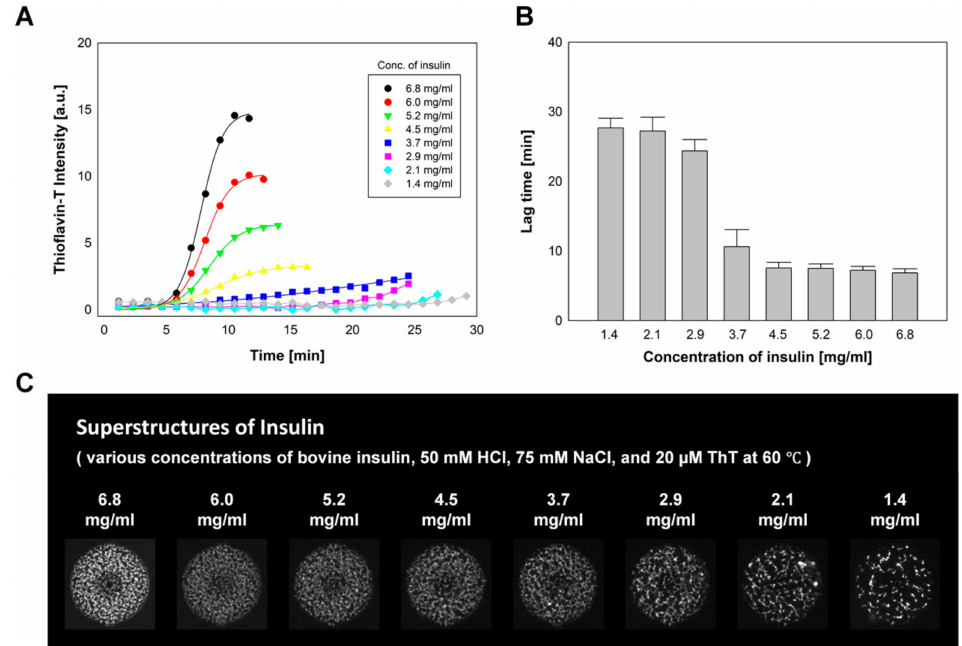
Figure 3. The e ff ect of insulin concentration on insulin fibrillation. ( A ) The fluorescent intensity changes of ThT as a marker of insulin fibrillation. ( B ) Average lag times for insulin fibril formation ( n = 8) and ( C ) the formation of insulin superstructures at various concentrations of insulin (50 mM HCl, 75 mM NaCl, and 20 µ M ThT).